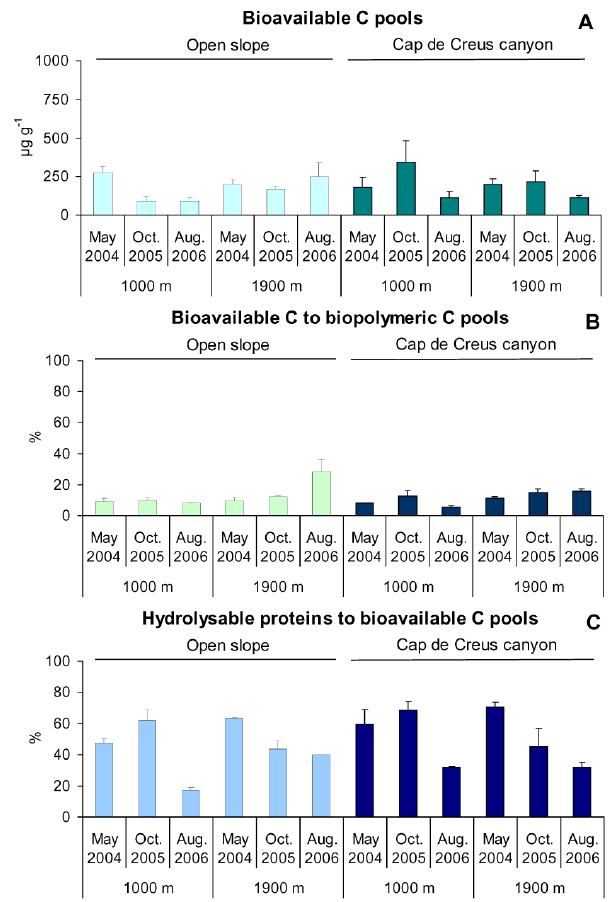
Fig. 4. Spatial distribution of (A) bioavailable C concentrations, (B) contribution of bioavailable C to biopolymeric C pools and (C) con- tribution of hydrolysable proteins (converted into C equivalents) to bioavailable C pools in surface sediments of the Cap de Creus canyon and adjacent open slope of the Catalan margin collected in the different sampling periods. Standard deviations are reported.